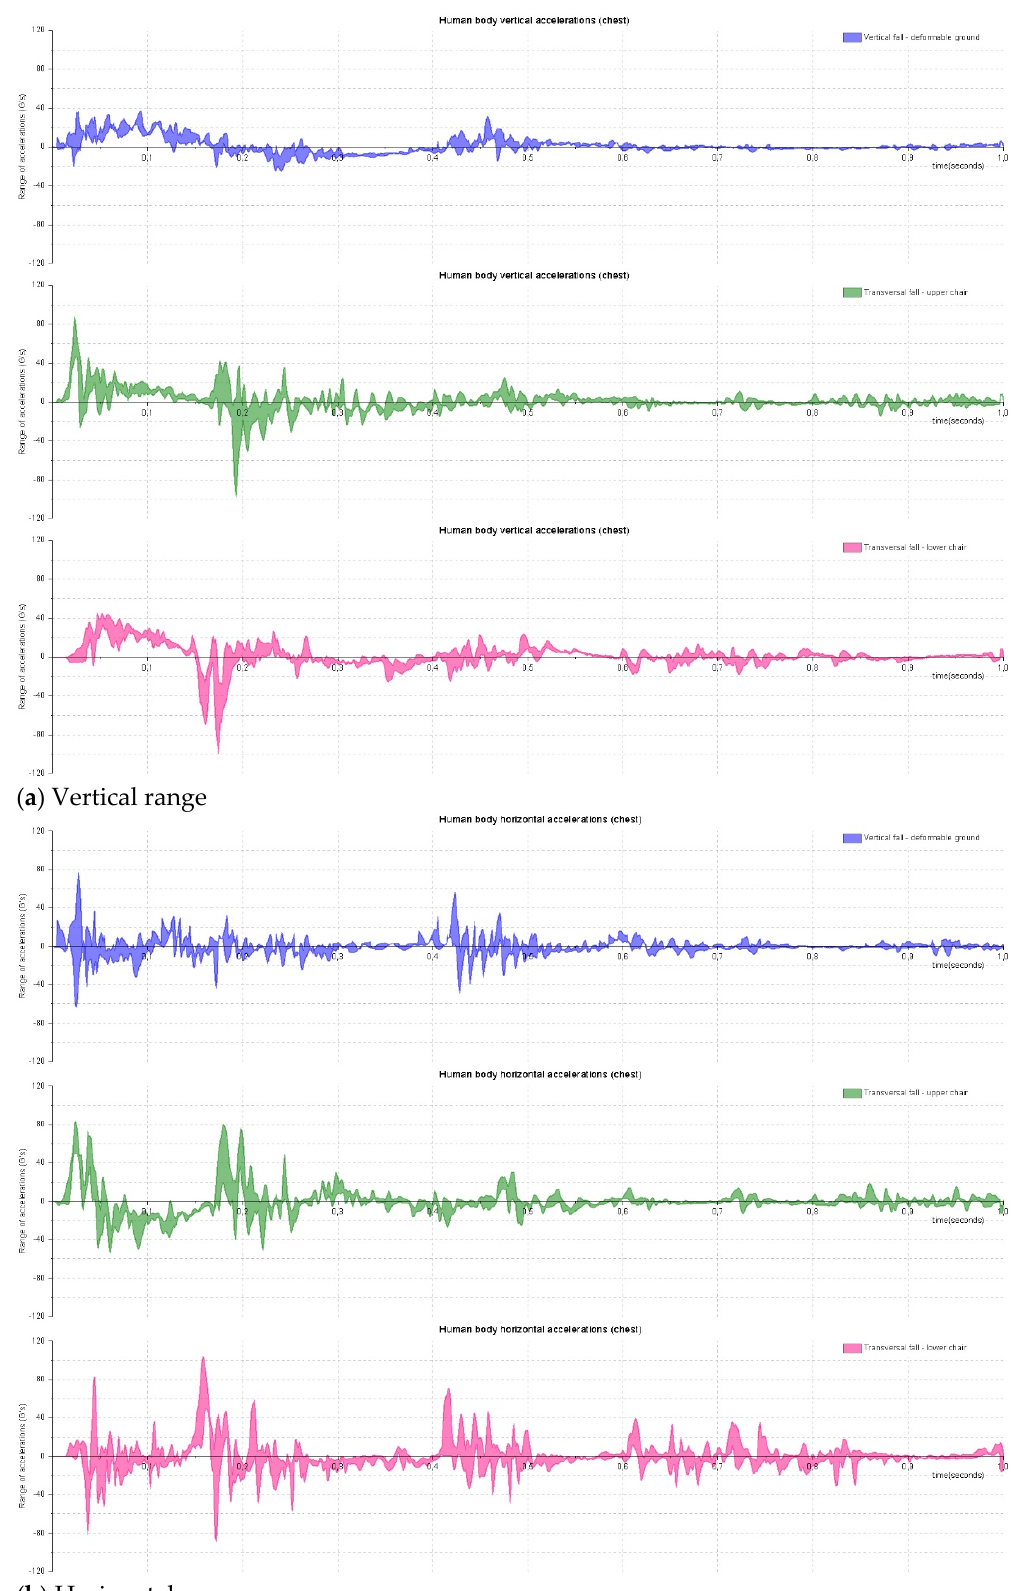
Figure 13. Spine vertebral accelerations (situation 1 to situation 3). This behaviour arises from the impacts of the body against the chest cushions, which is not the case for the vertical fall (situation 1). Thereafter, the vertical accelerations are